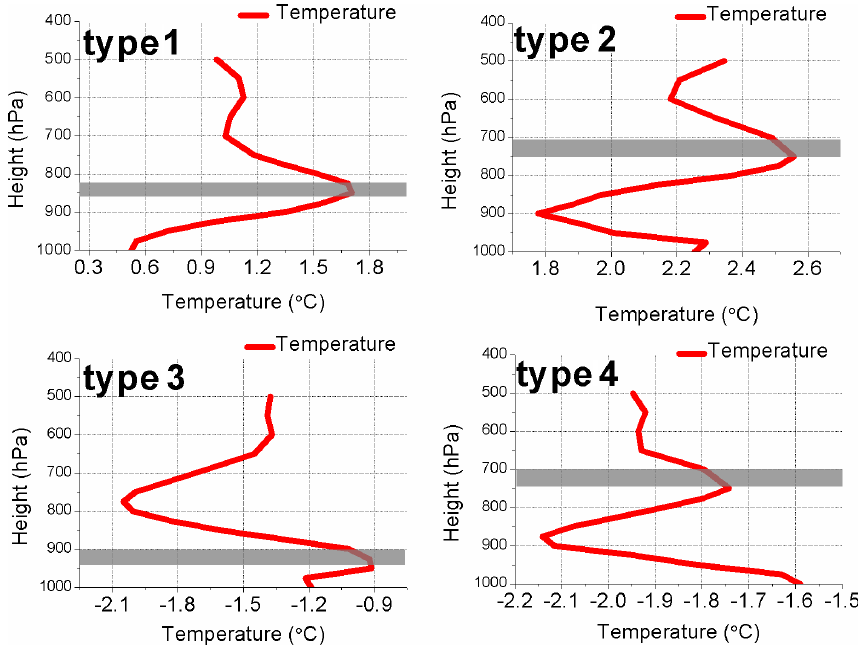
Figure 3. Vertical distribution of temperature in the pollution boundary layer of four types in the Beijing area. Solid red lines represent temperatures at different heights. Gray shade represents the top of the inversion